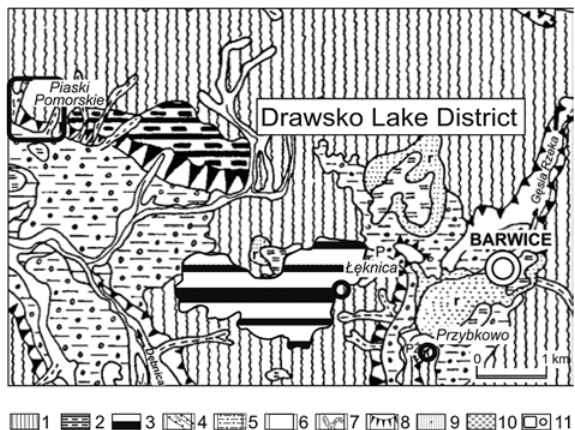
Fig. 2. Geomorphology of the research area (on the basis of the geomorphological sketch, Barwice sheet 1:100,000 Popielski 2000,